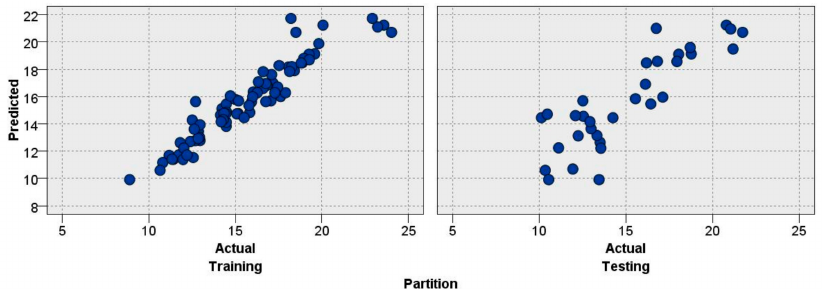
Figure 6. Testing and training results of RF model to predict the BI